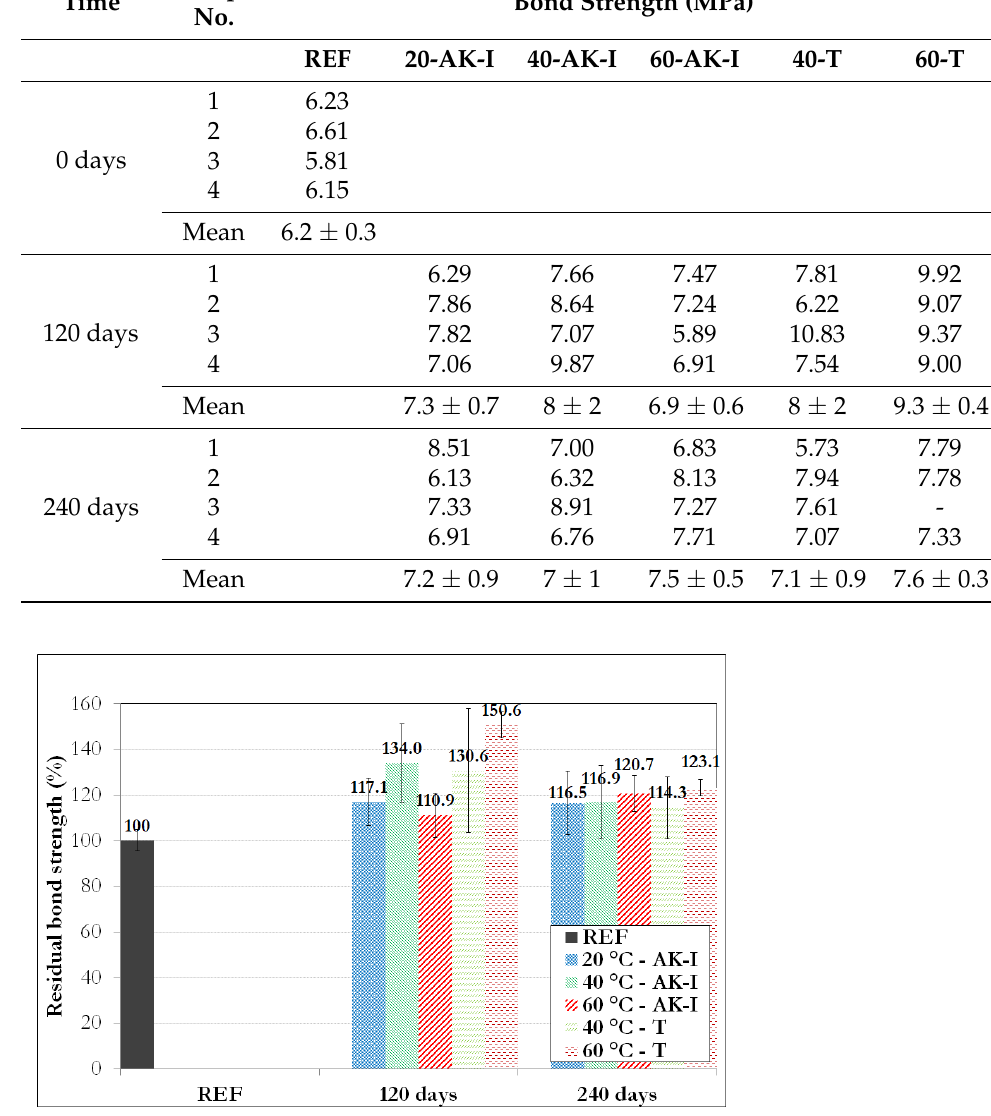
Figure 20. Residual bond strengths of pull-out specimens exposed to the different aging environments for different